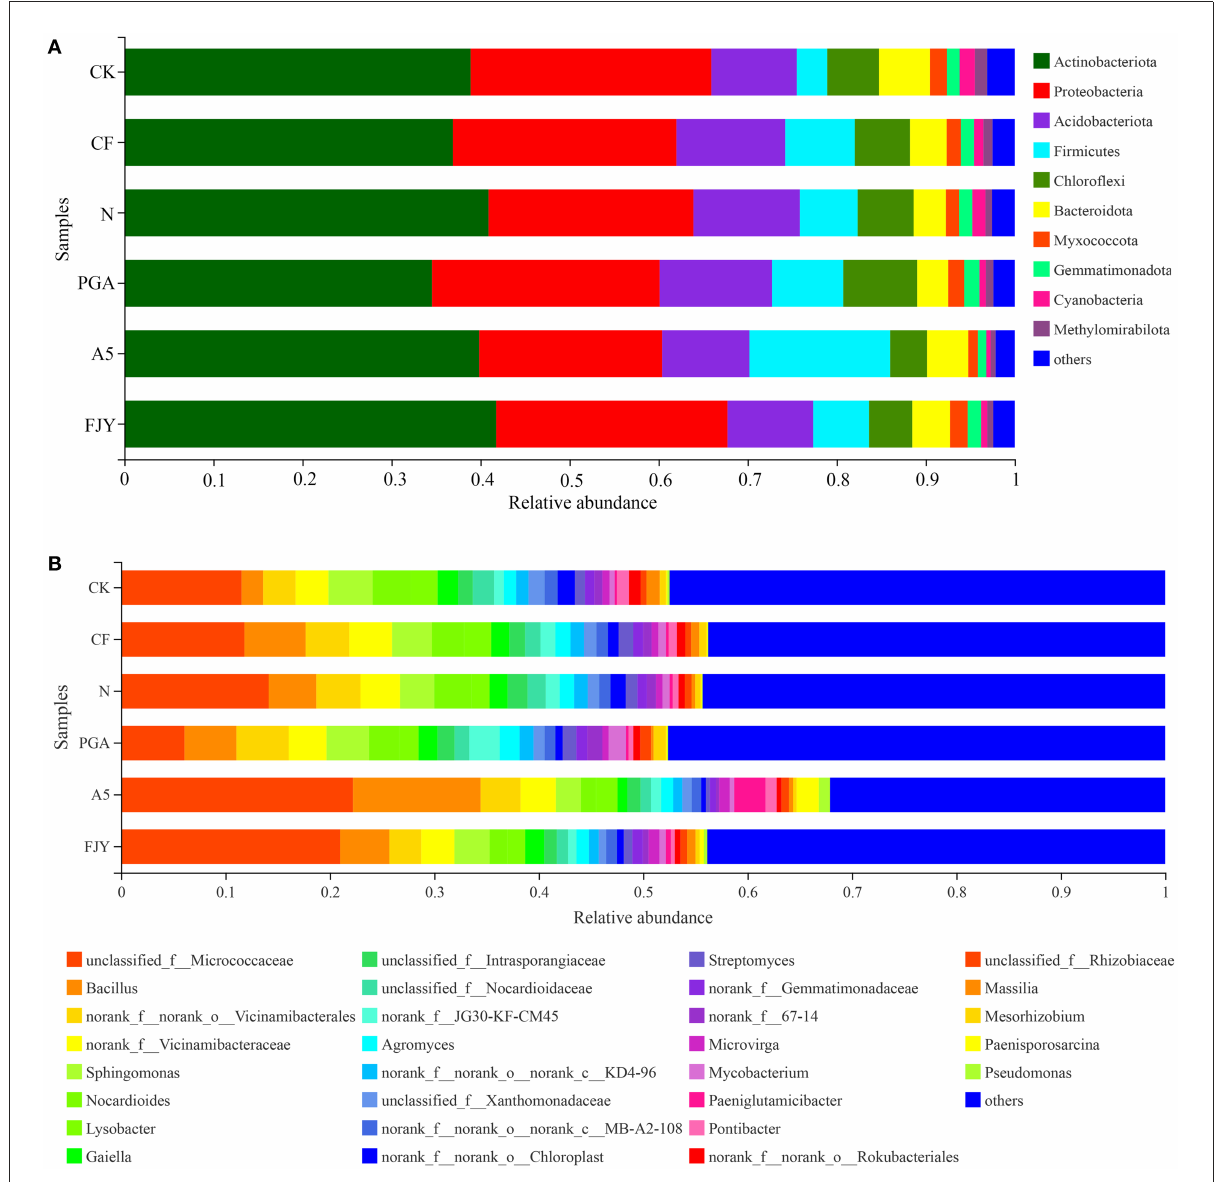
FIGURE4 The average relative abundances of bacteria at the phylum (A) and genus (B) levels for rhizosphere soil samples under different treatments. “Others” includes phyla/genera with a relative abundance below